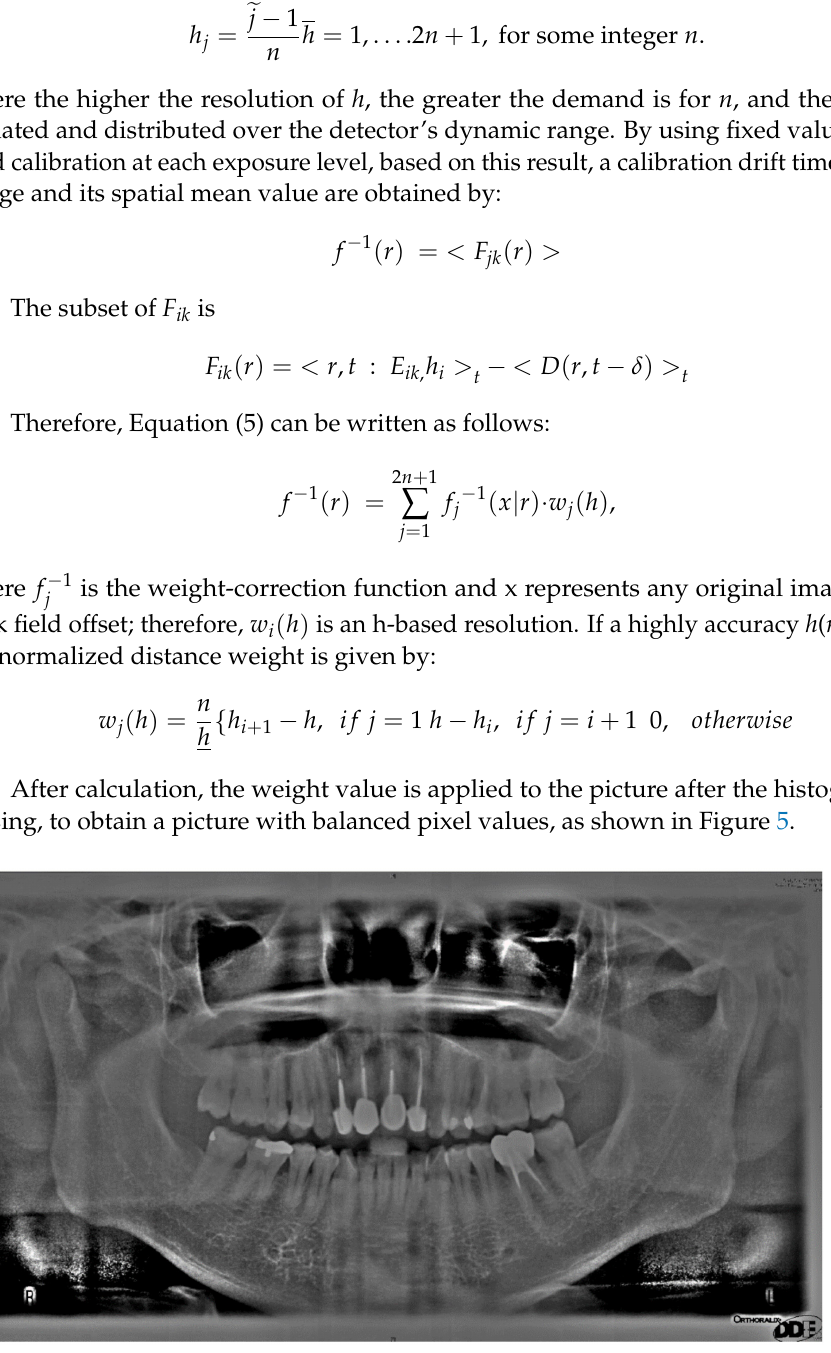
Figure 5. The balanced pixels after flat-field